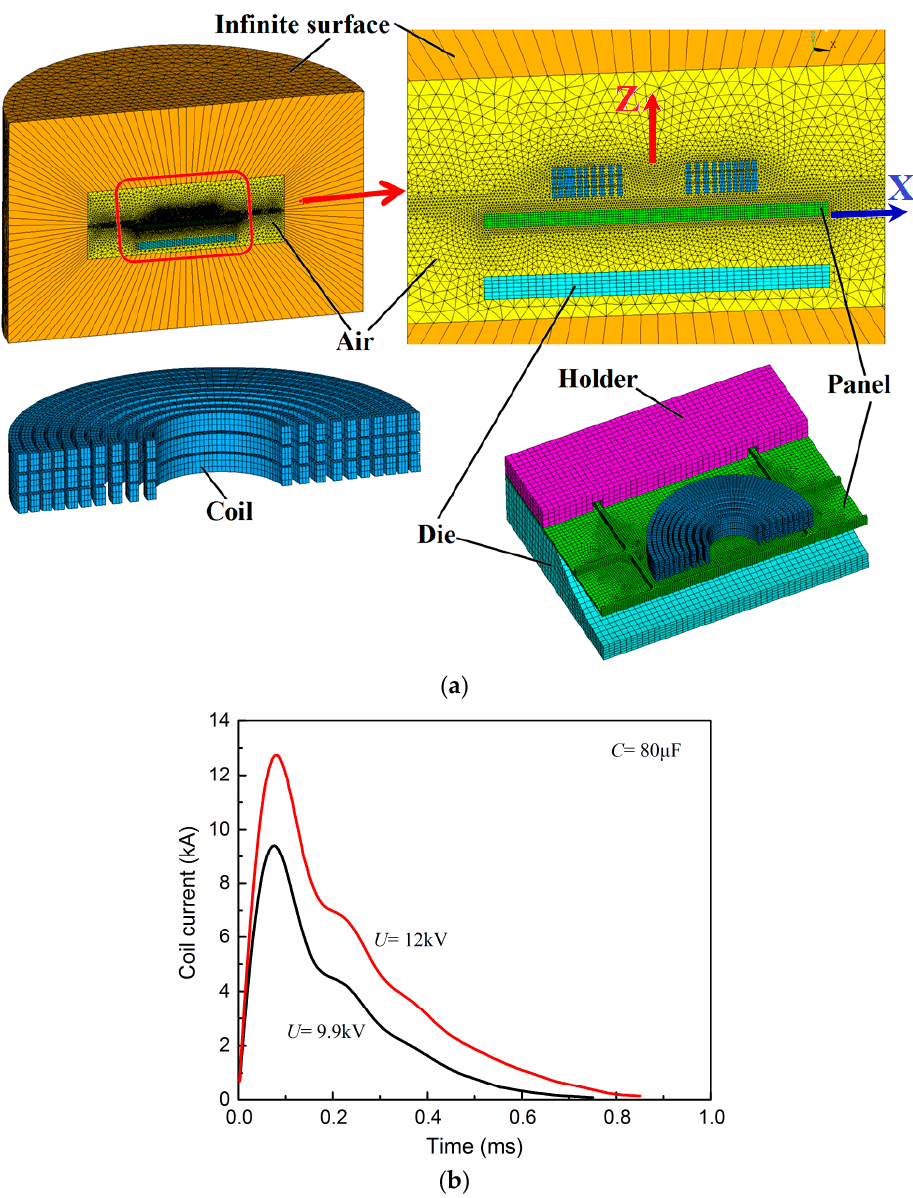
Figure 3. The finite element (FE) model for the stiffened panels during electromagnetic incremental forming (EMIF) process: ( a ) the meshed mode; and ( b ) the input experimental coil-current at different discharging voltages.